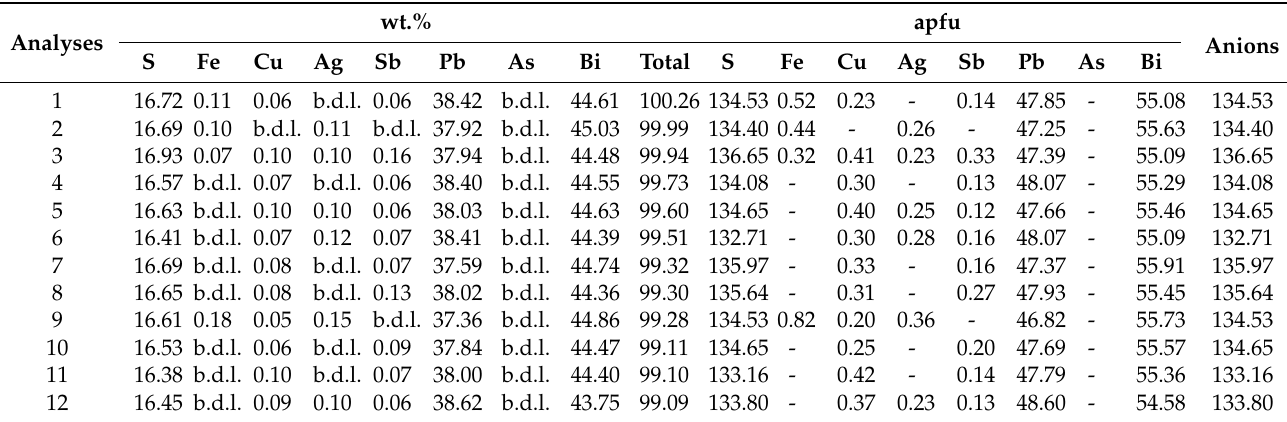
Table 7. Representative EPMA data for cannizzarite from the Kizhnica hornfels. The empirical formula was calculated based on the 104 cations [56], b.d.l. = below detection limit.